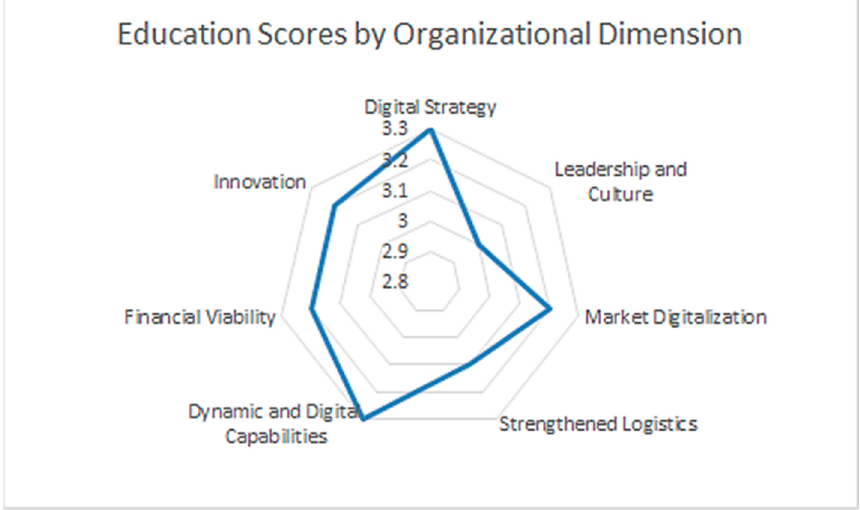
Figure 8. Organizational dimensions and cross-sectional variables gap analysis for education.